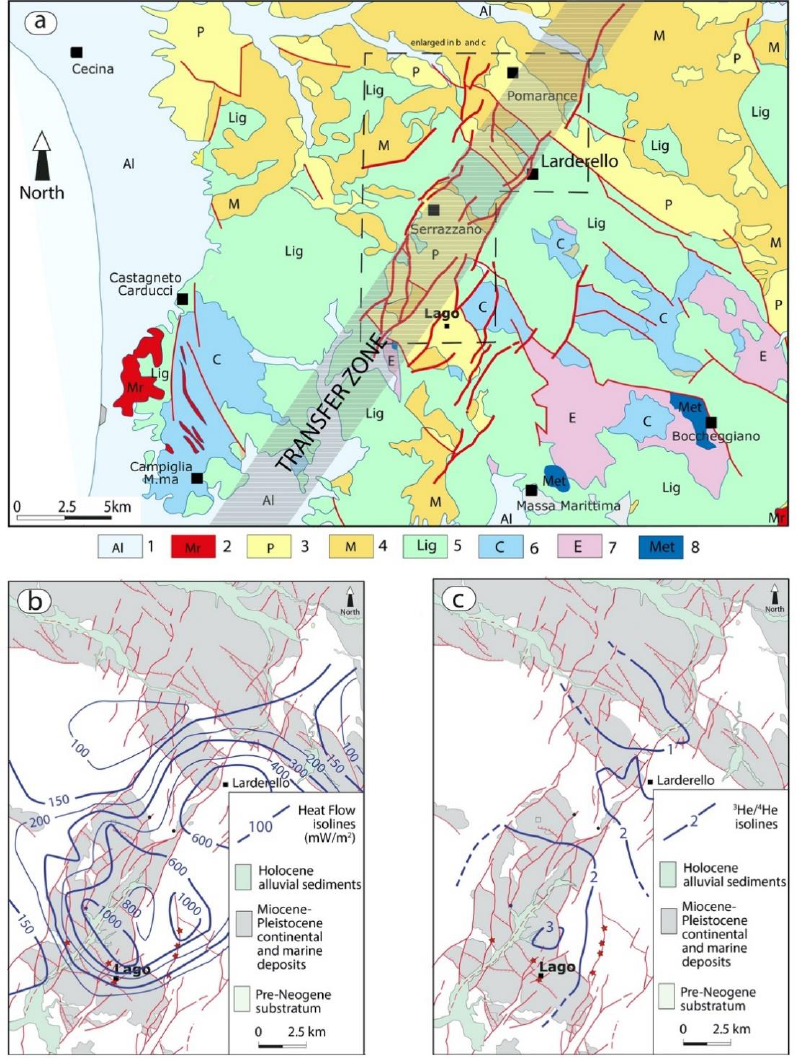
Figure 12. Larderello geothermal system: ( a ) Geological sketch map of Larderello and its surroundings. The transfer zone passing through the area is also indicated. Symbols: 1-Alluvial sediments (Holocene). 2-Magmatic rocks. (Pliocene-Pleistocene) Neogene deposits: 3-Marine deposits (Pliocene); 4-continental to marine deposits (Serravallian-Messinian). Ligurian Units: 5-Ophiolite and related sedimentary cover (Jurassic-Eocene) and carbonate-turbiditic succession (Eocene-Oligocene). Tuscan Units: 6-carbonate and terrigenous succession (Late Trias-Early Miocene); 7-evaporite (Late Trias); 8-metapelite and quartzite (Paleozoic-Late Trias). ( b ) contour lines indicating the heat flux in the study area: the highest values are located where the substratum of the Neogene sediments is deeper; ( c ) distribution of the 3 He/ 4 He ratio in the study area: the mantle contribution is highest where the substratum of the Neogene sediments is deeper (after Reference [29]).